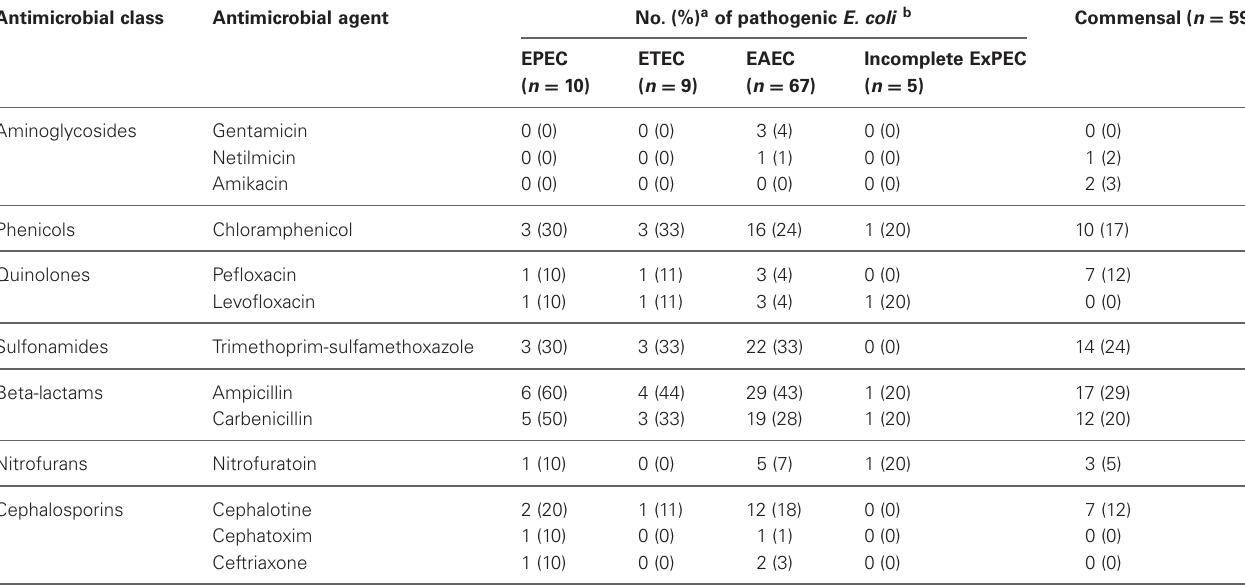
Table 4 | Antimicrobial resistance found in potentially pathogenic and commensal Escherichia coli . Antimicrobial class